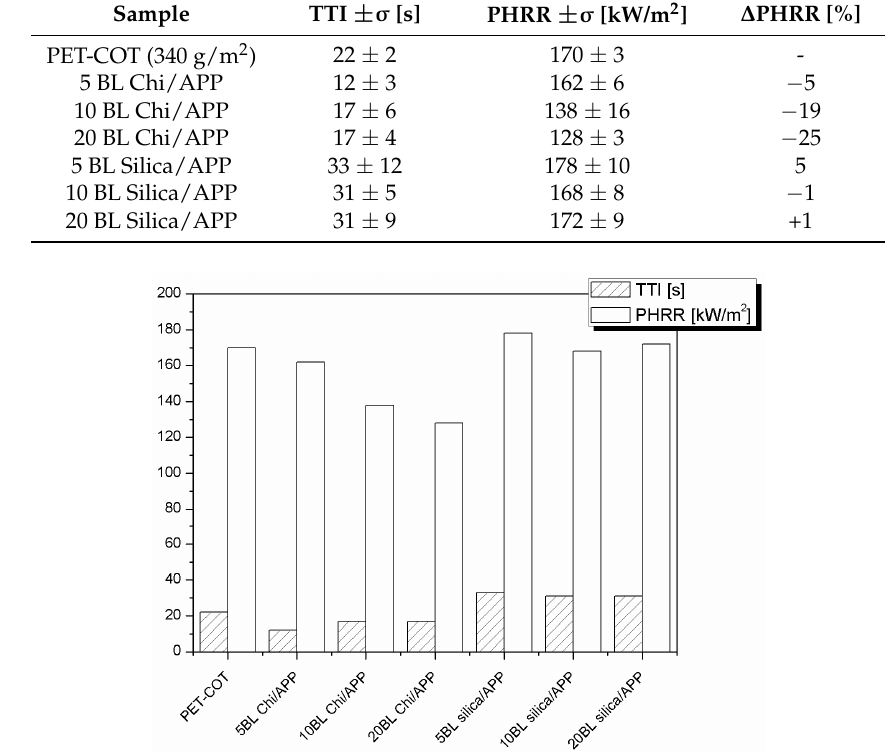
Table 15. Combustion data of untreated and BL-treated PET-COT by cone calorimetry (35 kW/m 2 ) [30]. Sample